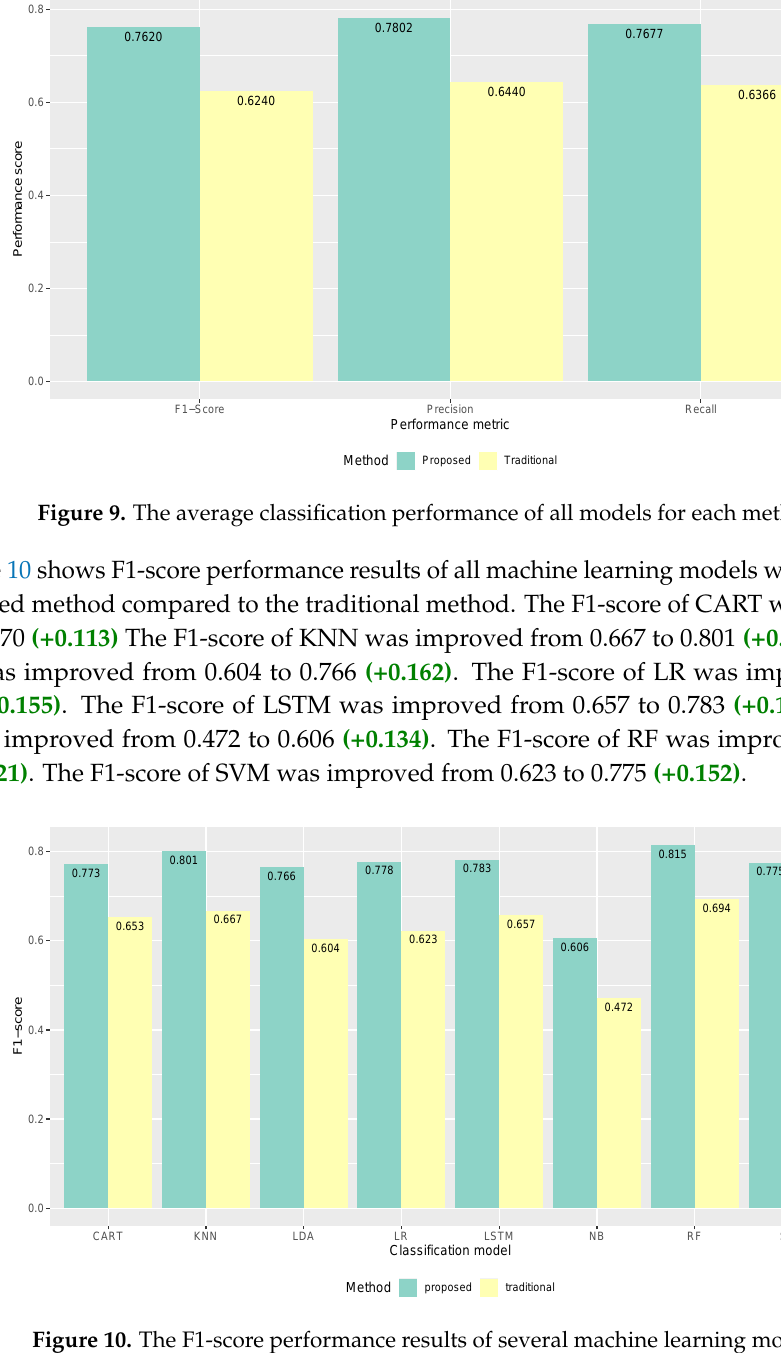
Figure 10. The F1-score performance results of several machine learning